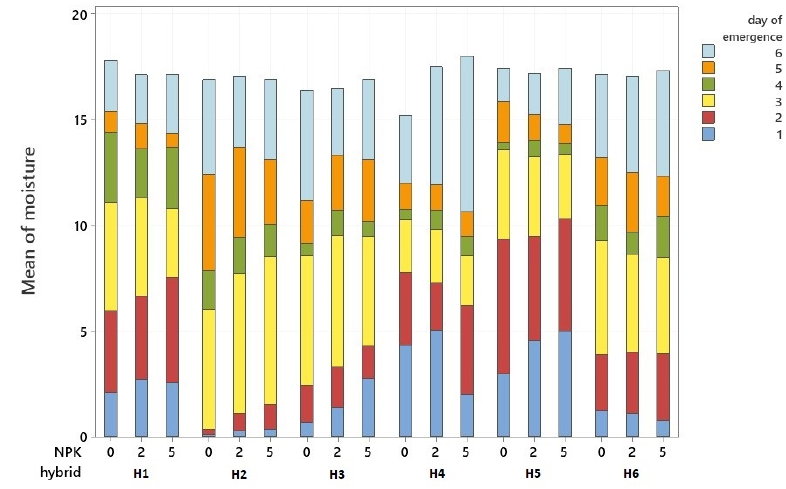
Figure 6. Interaction between hybrids, fertilizer, and day of emergence on moisture content.